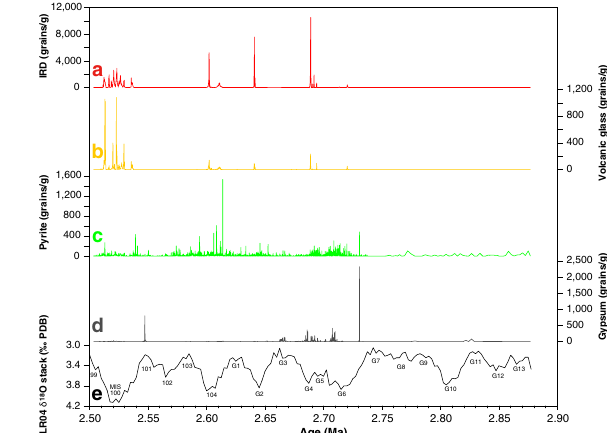
Fig. 7 Non-biological coarse grains (>150 μ m) included in analysis samples. a , b Abundances of IRD and volcanic glass. c , d Abundances of pyrite and gypsum formed during diagenesis. e LR04 global δ 18 O stack 16 .